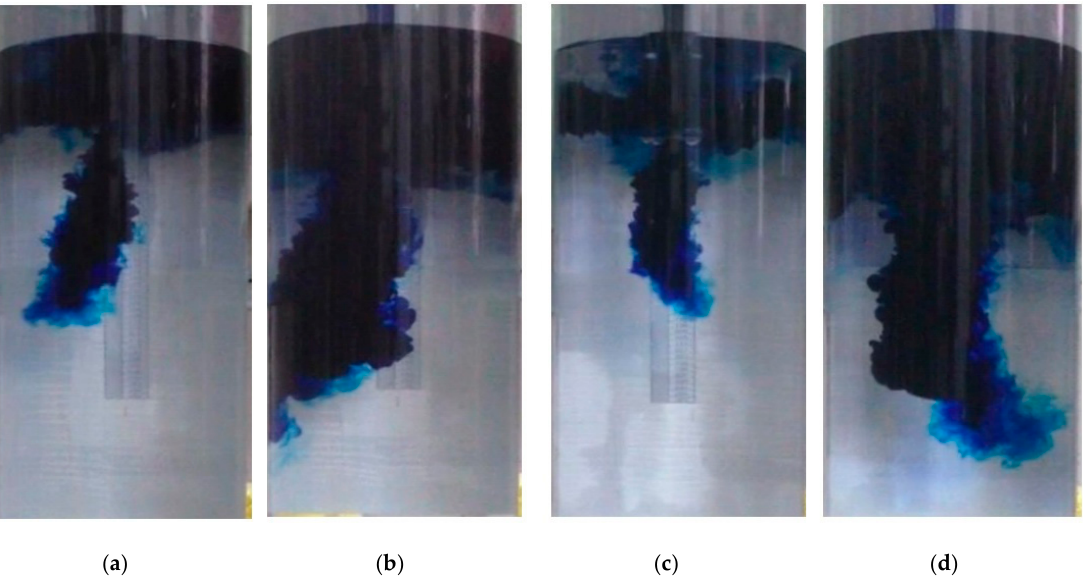
Figure 21. The flow field of the mold at different times while using different SENs in water model. ( a ) Original nozzle at t = 0.5 s; ( b ) Original nozzle at t = 2 s; ( c ) Optimized swirling nozzle at t = 0.5 s; ( d ) Optimized swirling nozzle at t = 2 s.